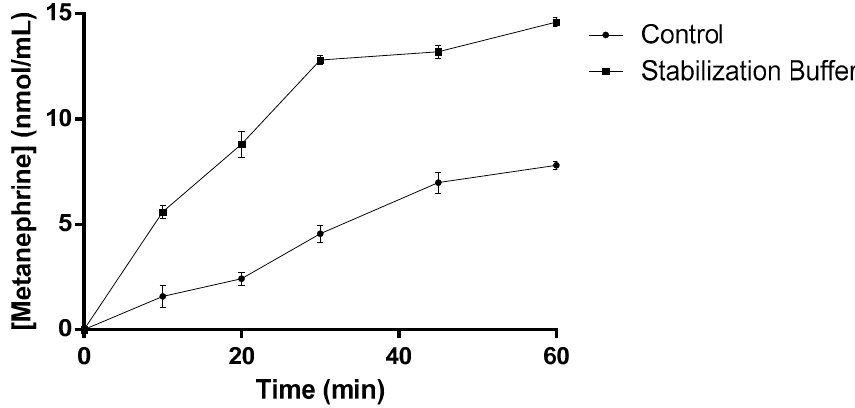
Figure 9. Metanephrine concentration over time obtained in the absence and presence of the stabi- lization solution formulated in the course of this work.